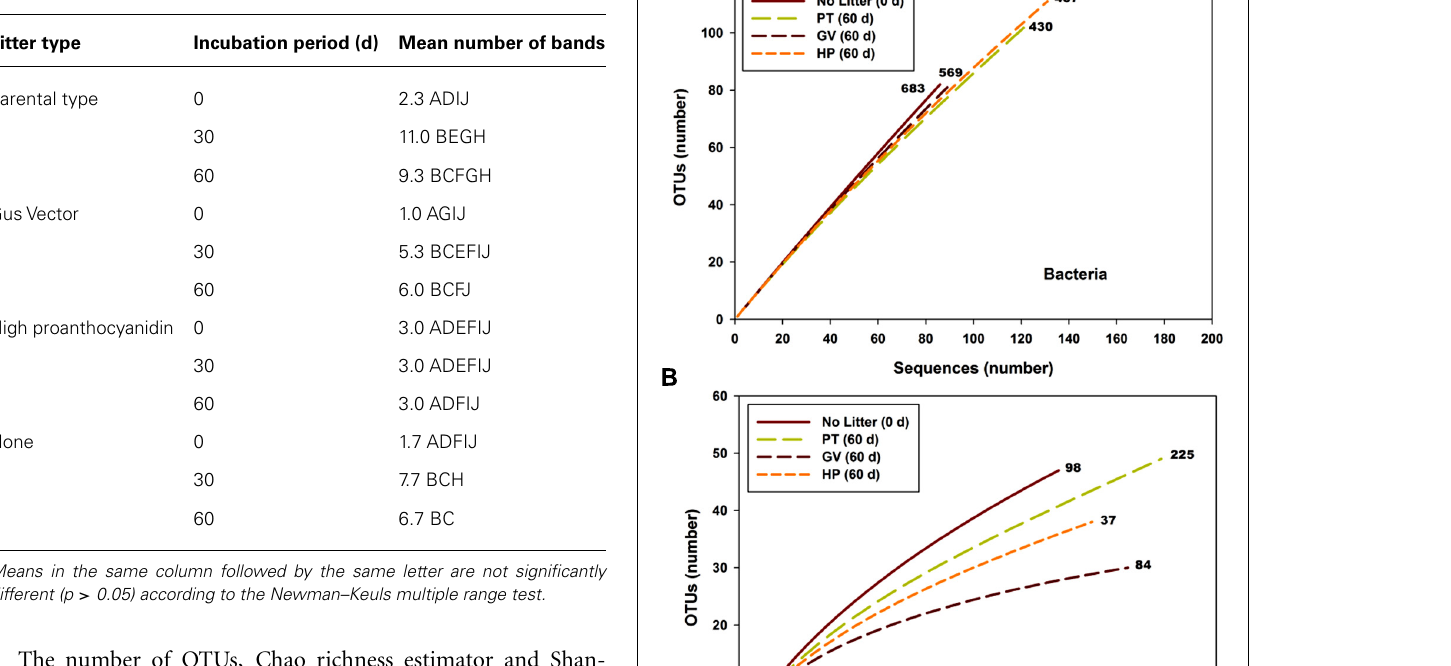
Table 3 | Mean number of 18S rDNA DGGE bands detected in DNA extracted from microcosm soils with poplar litter, after incubation for up to 60 d.